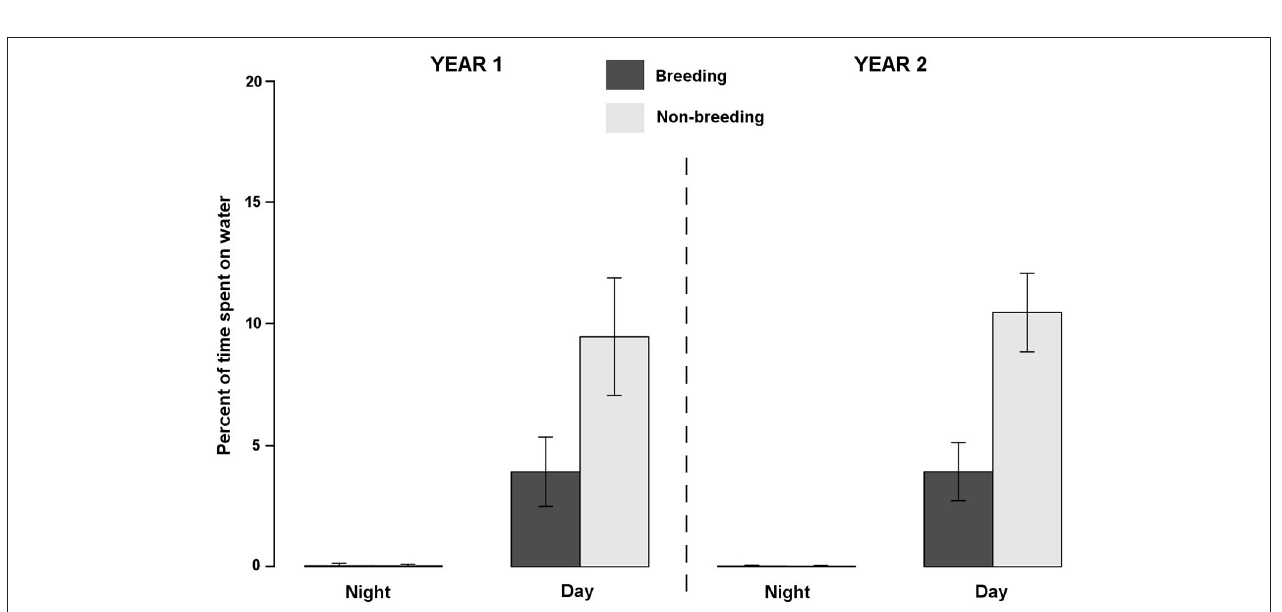
FIGURE 2 | Example of non-breeding at-sea distribution estimation of four sooty terns from Bird Island equipped for 2 years (2011–2012 and 2012–2013). In white: the first year tracks, in red: the second year tracks. Units are in degrees.